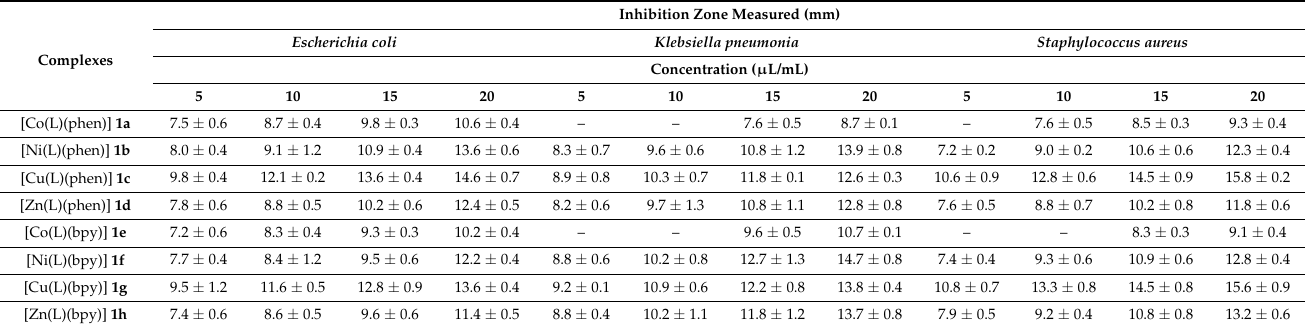
Table 11. Antibacterial activity of metal (II) complexes 1 ( a – h ) against pathogenic bacteria tested at various concentrations by an agar diffusion